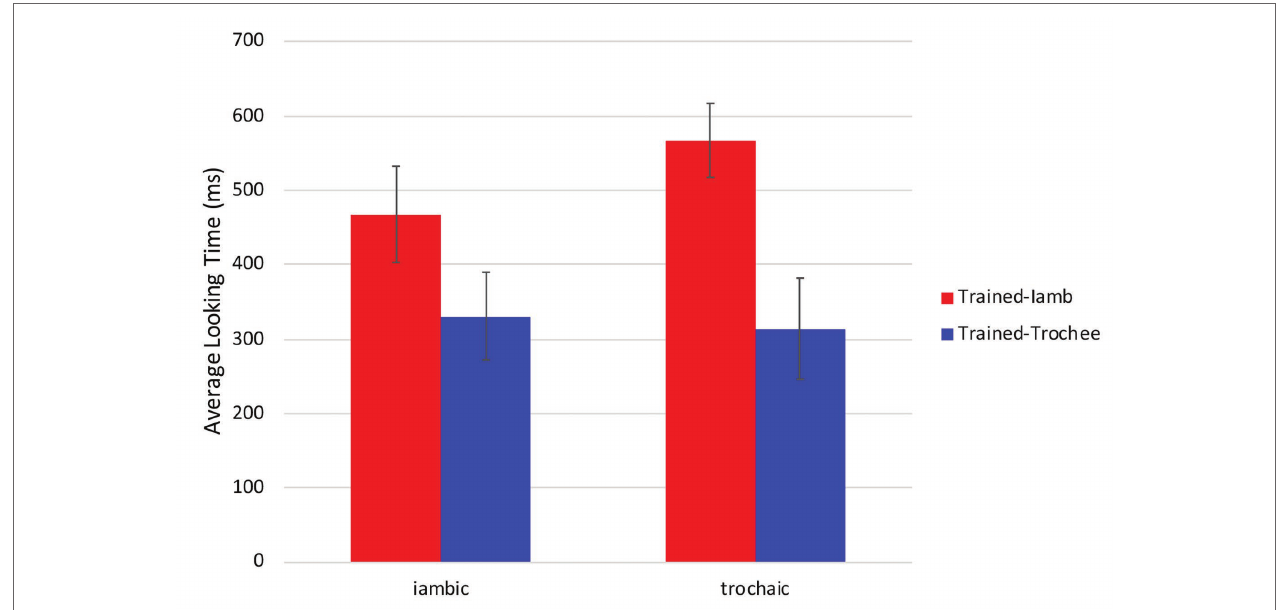
FIGURE 6 | Average looking times (in milliseconds) to the iambic and trochaic trained side during iambic and trochaic test trials. Error bars indicate the standard error of the mean